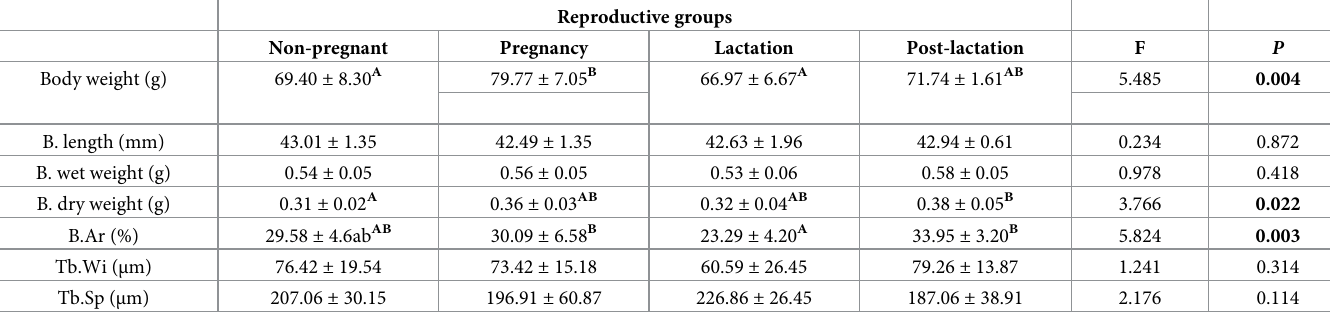
Table 1. Macroscopic and microstructural parameters in female bats ( Artibeus lituratus